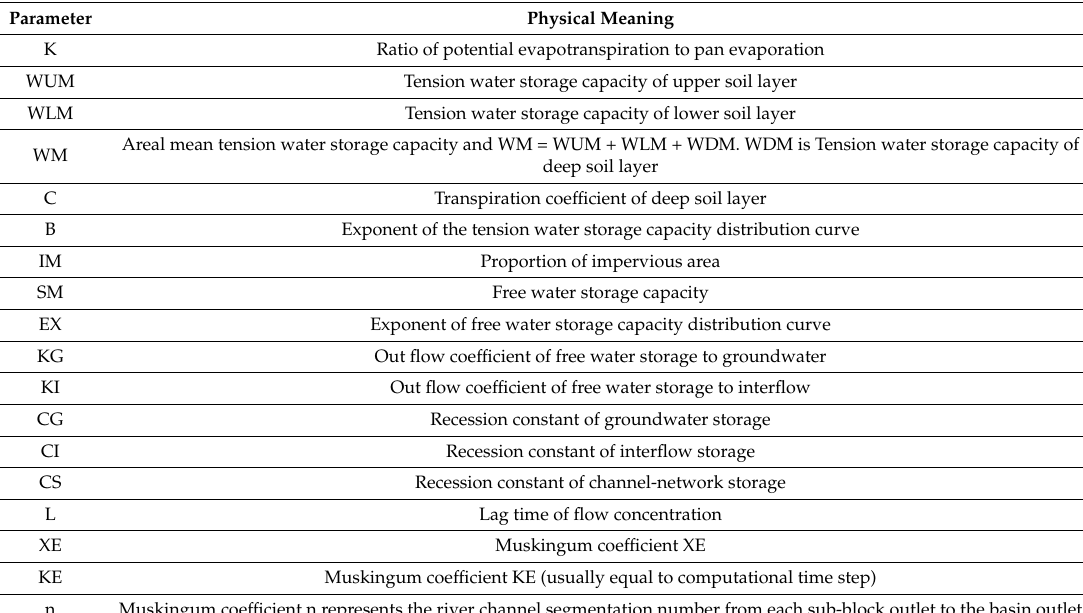
Table 1. Parameters of the Xinanjiang model.